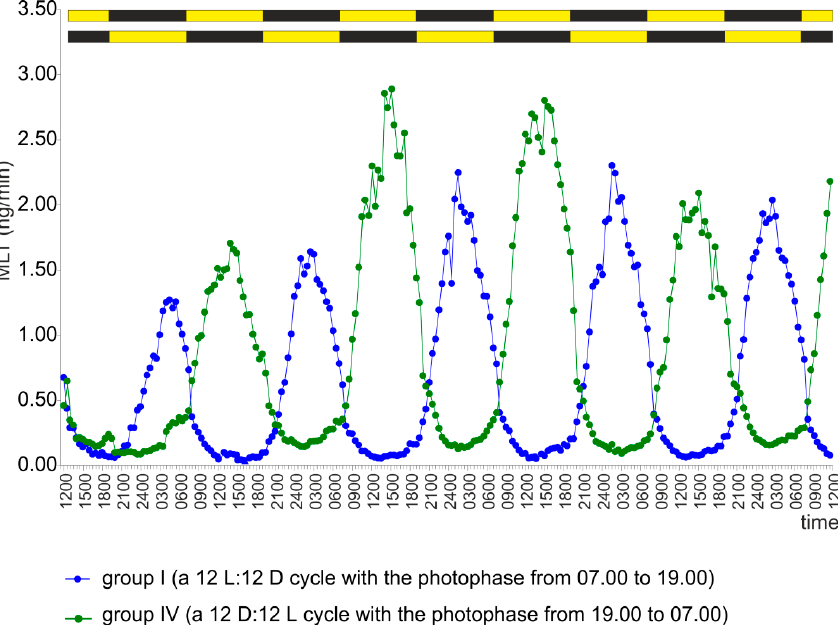
Figure 2. Experiment I. Secretion of MLT (mean) from turkey pineal organs incubated under a 12 L:12 D cycle with the photophase from 07.00 to 19.00 (group I) or a reversed cycle of 12 D:12 L (group IV) during five consecutive days.